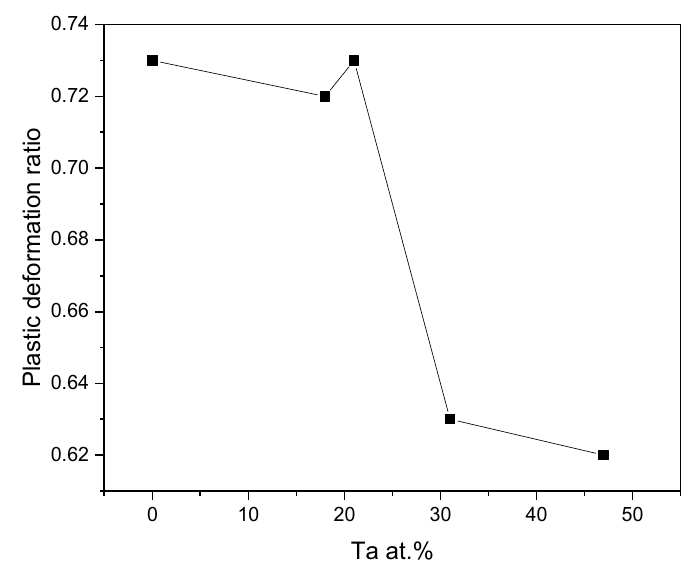
Figure 5. Evolution of plastic deformation ratio as a function of tantalum content.